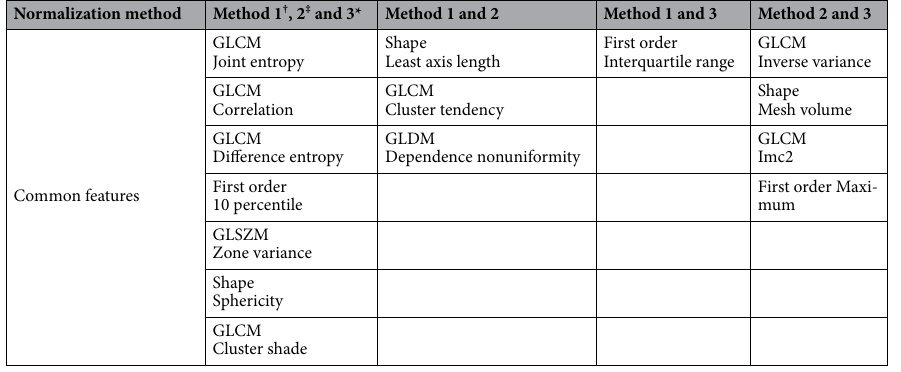
Table 2. Common features among the top 20 original radiomic features from each normalization method for malignant tumor prediction † Normalization method covering all voxels from whole image. ‡ Normalization method covering the voxels from VOI only. *Normalization method covering the voxels from VOI and its 2 mm-dilated circumference.